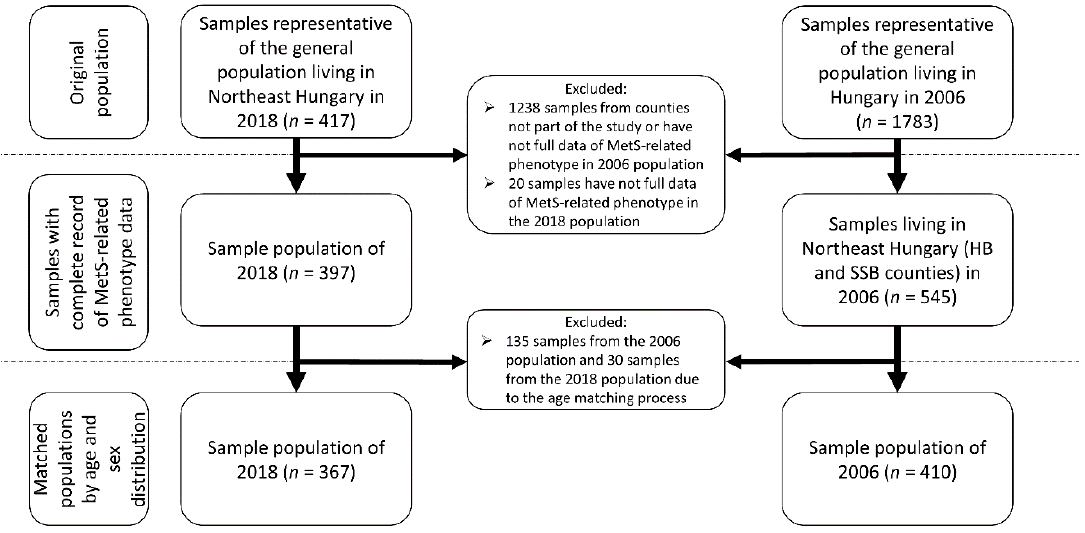
Figure 1. Process of sample selection of the study populations.